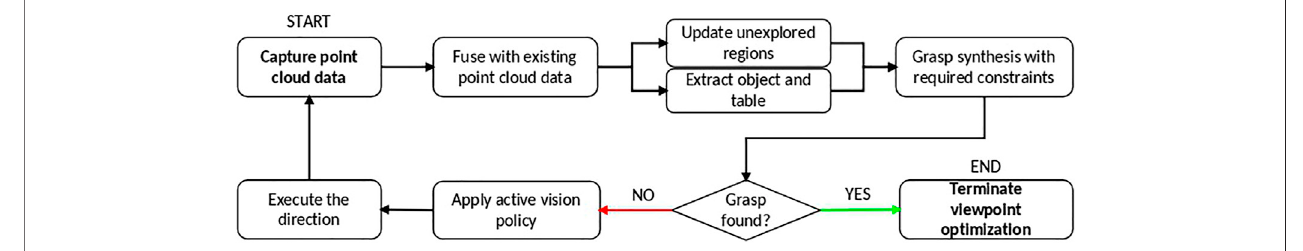
FIGURE 2 | The active vision based grasp synthesis pipeline.